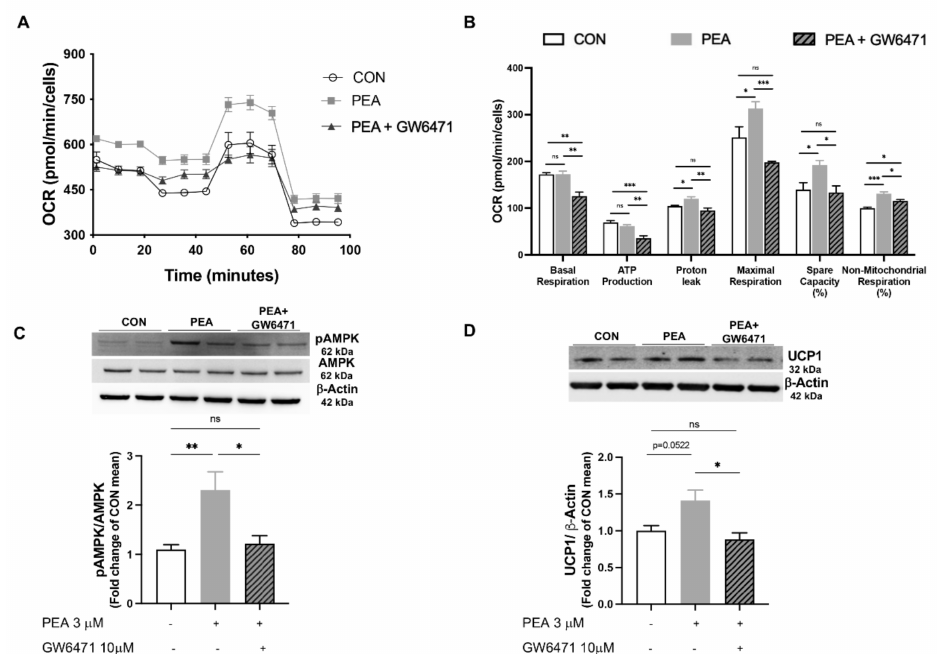
Figure 4. PEA exerts its metabolic effects via PPAR- α activation in differentiated 3T3-L1 cells. ( A ) Mito stress assay is performed in differentiated adipocytes, in the presence or not of PEA (3 µ M) and/or the PPAR- α antagonist GW6471 (10 µ M), by the Seahorse analyzer XFe24; ( B ) key parameters of mitochondrial function are reported. Western blot analysis for ( C ) phospho-AMPK and ( D ) UCP1 are also displayed. Results are shown as mean ± SEM of three different sets of experiments for 3T3-L1, respectively. * p < 0.05, ** p < 0.01, *** p < 0.001 significantly differ from